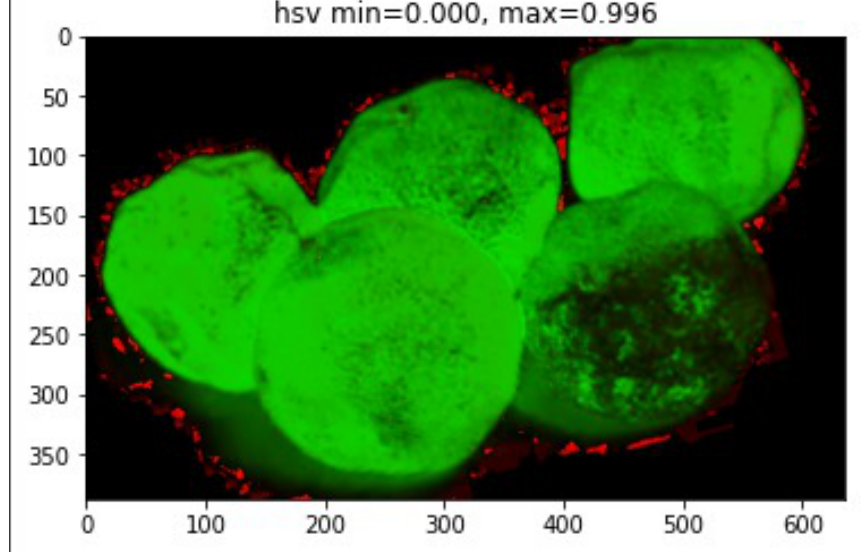
Figure 5. HSV image with min–max values. The sum of the histogram intersection of color 𝑆𝑖𝑚 𝑐𝑜𝑙𝑜𝑟 ( 𝑟 was calculated to mea- 𝛼 , 𝑟 𝛽 ) sure the color similarity. One-dimensional color histograms were derived for individ- ual color channels for each region using 25 bins, which was found to be effective. Three RGB color channels resulted in a color histogram with dimensions d = 75 for each region. The L 1 norm was used to normalize the color histograms. The histogram intersection was used to determine the similarity using Equation